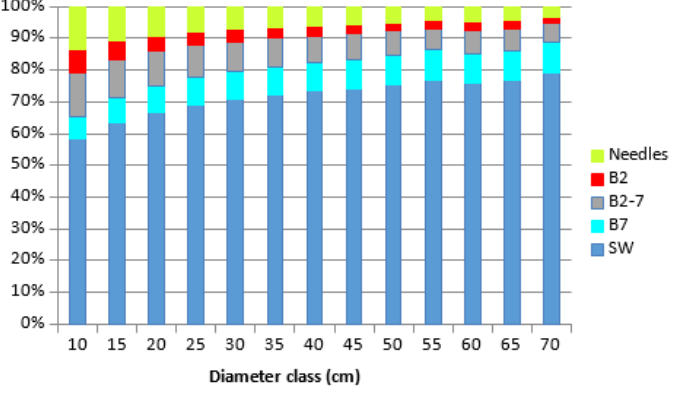
Figure 3. Graphic of aboveground biomass fractions. Table 4. Aboveground biomass (dry matter, Gg) and its annual growth (Gg year − 1 ) in Biscay.